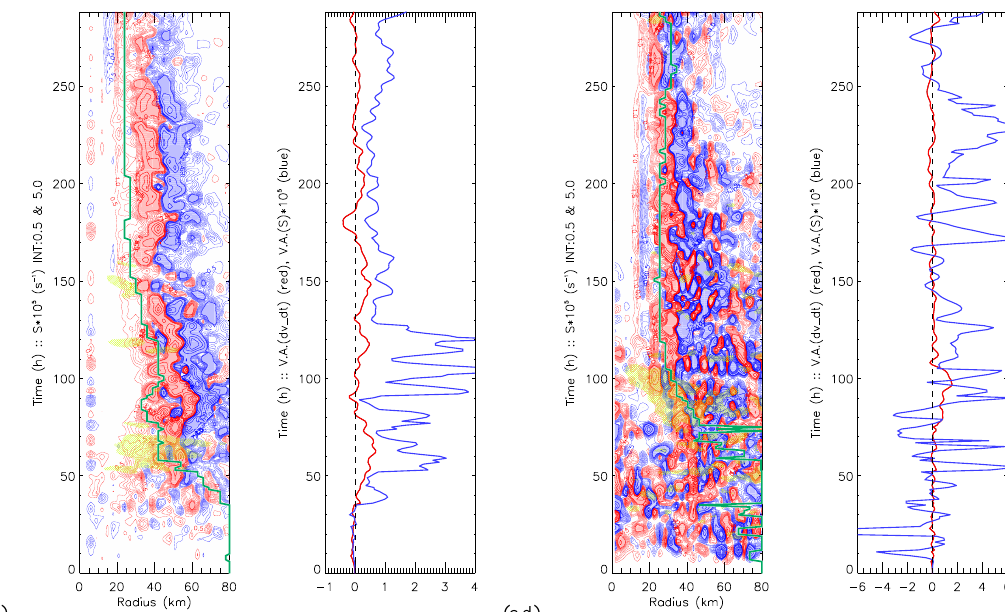
Fig. 9. Panel (a): Radius-time plot of layer-averaged spin-up function, ¯ S for the simulation 3D3k. Red contours denote positive values of ¯ S , blue contours denote negative values. Thin contour interval 1 × 10 − 5 s − 1 up to magnitude 4 × 10 − 5 s − 1 ; thick contour interval 5 × 10 − 5 s − 1 . Zero contour is omitted. Yellow shading denotes regions where layer-averaged intensification rate for the gradient wind exceeds ∂ ¯ v g /∂t> 0 . 5 m s − 1 h − 1 ; thick green curve denotes the radius of maximum ¯ v g . For reasons given in the text, the layer average used comprises a height spanning the bulk of the troposphere ( 1 . 5 <z < 12 km), but purposefully omits the frictional boundary layer ( 0 <z < 1 . 5 km) and outflow layer ( z > 12 km) of the developing storm where axisymmetric balance dynamics formally breaks down. Panel (b): Time series of the volume-averaged spin-up function ˆ S in units of 1 × 10 − 5 (s − 1 ) (blue) and volume-averaged gradient wind tendency (in units of m s − 1 h − 1 ) (red). The volume averaging is carried out from the axis of rotation to the radius of maximum layer-averaged gradient wind (thick green curve in panel (a)) and over the same height as employed in panel (a). Panels (c) and (d) are the corresponding plots for the axisymmetric simulation AX3k. The contour intervals are identical. All fields have a Gaussian time smoother applied prior to averaging.